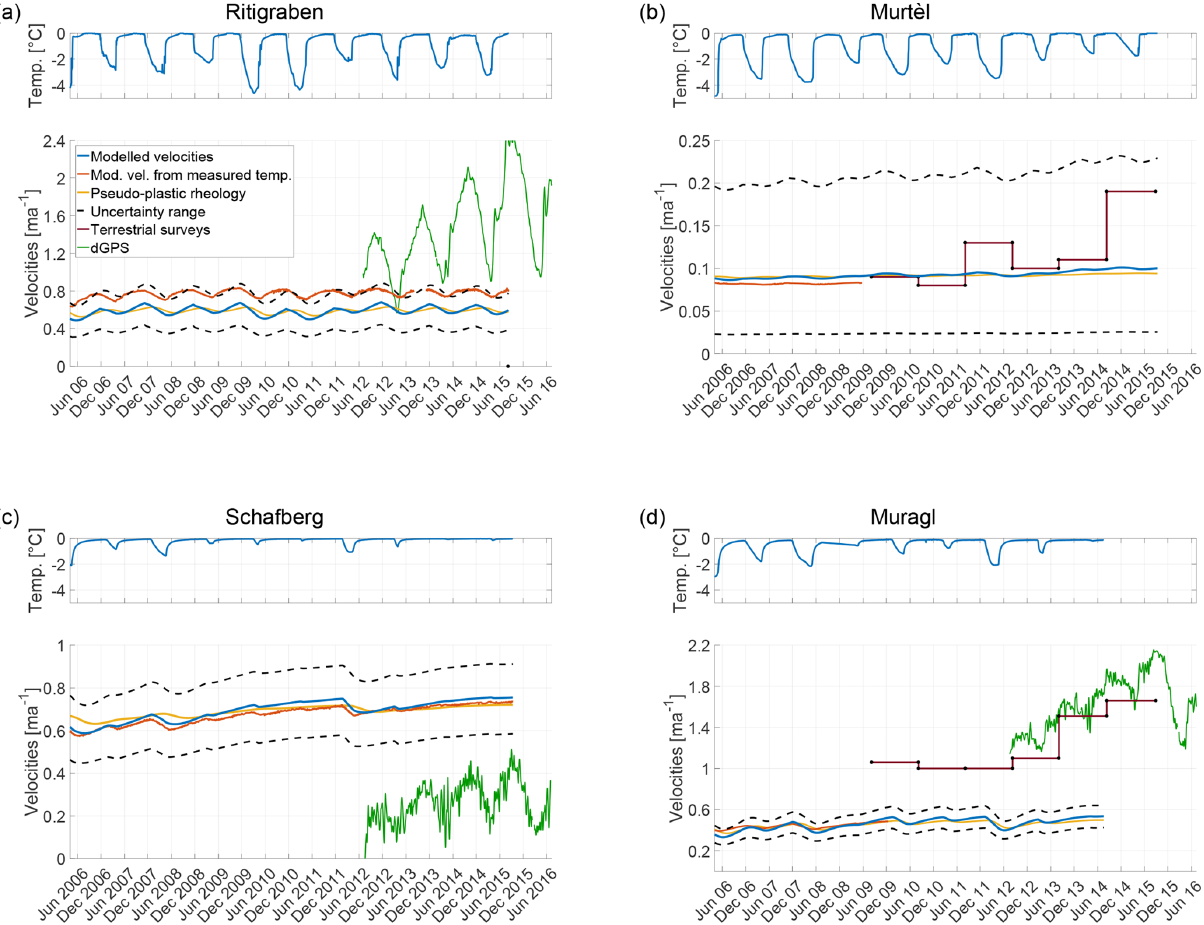
Figure 4. Observed and modelled surface flow velocities for (a) Ritigraben, (b) Murtèl, (c) Schafberg and (d) Muragl rock glaciers. The upper subpanel shows the observed subsurface temperature used as model input. The lower subpanel shows the modelled and observed velocities. The modelled velocities are shown for using the modelled temperatures (solid blue line), the observed temperature fields (red solid line), and the pseudo-plastic rheology (yellow solid line). The uncertainty range resulting from variations in slope ( ± 2 ◦ ), volumetric ice content (within the proposed range; see Fig. 3 and Table 2) and thermal diffusivity ( ± 0 . 02m 2 day − 1 ) is plotted with black dashed lines. The modelled velocities are compared with the observed velocities from terrestrial surveys (dark solid red line with black dots) and with DGPS measurements (green solid